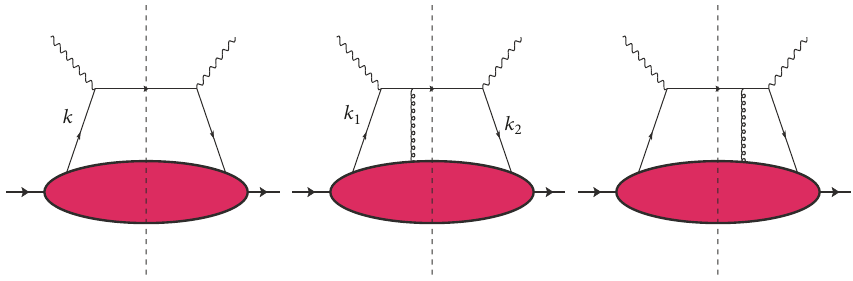
Figure 1: A series of LO diagrams in the diagrammatic